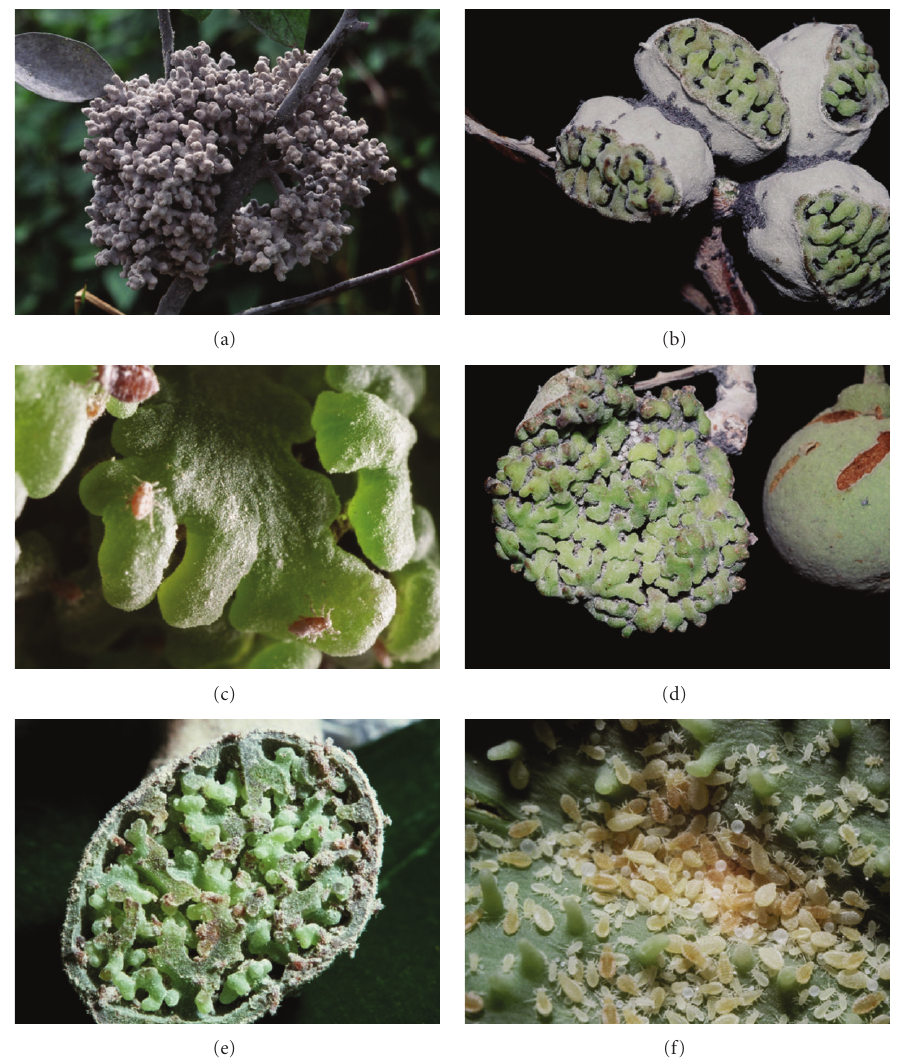
Figure 12: (a) A gall of Tuberaphis owadai on Styrax tonkinensis (PhaDin, Vietnam; 12 September 1995). (b) A gall of Pseudoregma sundanica on Styrax paralleloneurus ; many soldiers (dark gray in color) reside on the outer surface of the gall, mainly on the basal parts of the subgalls (Mt Sibayak, Sumatra; 2 August 1996). (c) Outer surface of a gall of Tuberaphis takenouchii on Styrax formosanus ; aphids live among ramified solid projections (Habon, Taiwan; 4 November 2003). (d) A once-broken gall of P. sundanica on S. paralleloneurus and a fruit of the host tree (Mt Sibayak; 2 August 1996). (e) A cut subgall of Ceratoglyphina styracicola on Styrax suberifolius , showing ramified solid projections developing inside (Sun Moon Lake, Taiwan; July 1986; photo by N. E. Pierce). (f) A cut subgall of Astegopteryx nipae on S. benzoin , showing short solid projections (Gombak Rd., Malay Peninsula; 2 December 1992; photo by D. L.